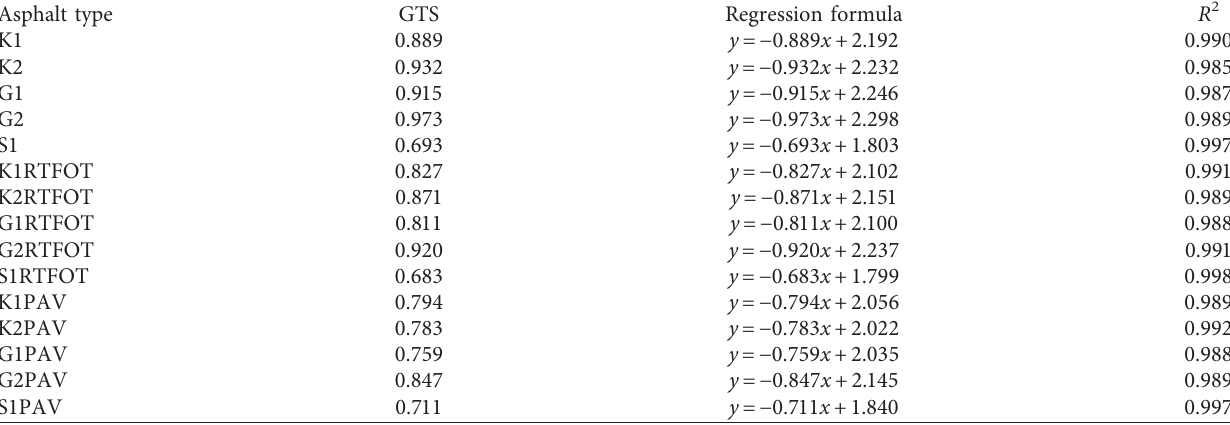
Table 5: Asphalt GTS value and regression equation.